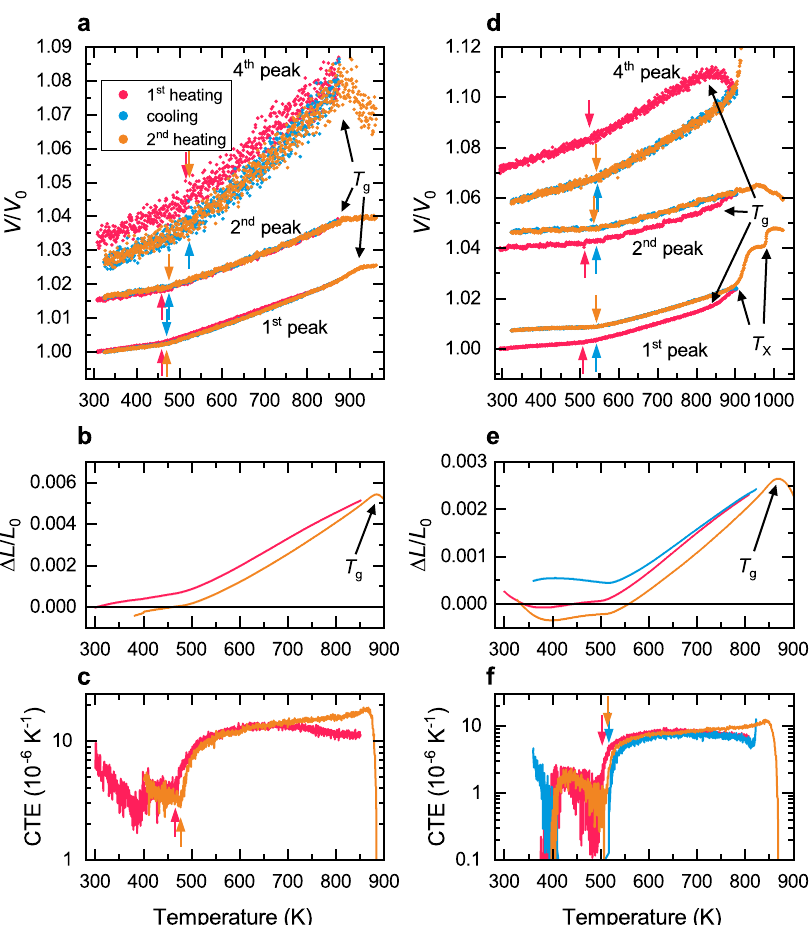
Fig. 2 Relative volume expansion of QNb and QMo derived from the XRD patterns and macroscopic dilatometry. The volume derived from XRD for a QNb and d QMo is offset for better visibility. The b length and c CTE of QNb shows the same expansion behavior as the XRD-derived volume change. The same applies to the e length and f CTE of QMo. The temperature at which the CTE increases is marked by arrows.